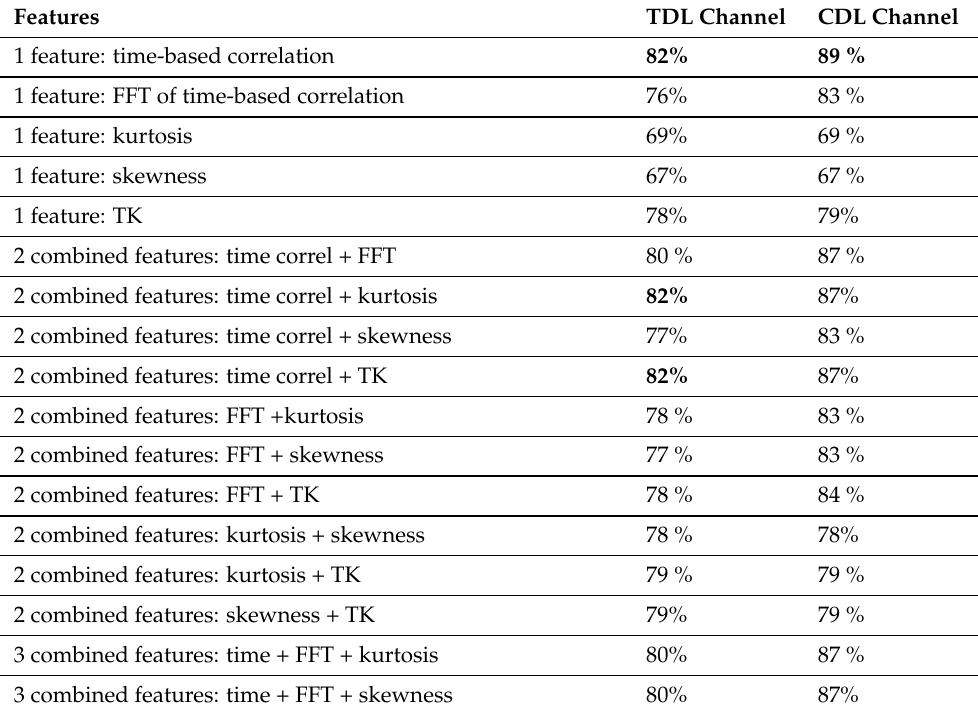
Table 4. Impact of feature selection on the detection accuracy. PRS signals, average results for SNR uniformly distributed between − 20 dB and 0 dB. Highest values are emphasized in bold-faced